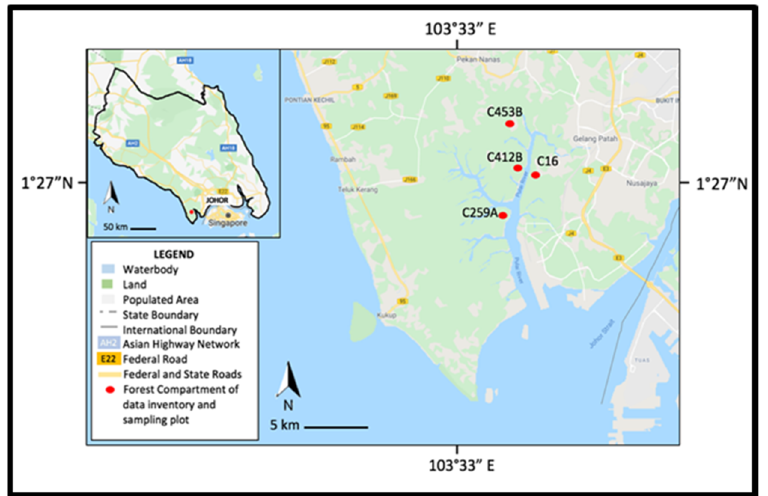
Figure 1. Study area in the Sungai Pulai Forest Reserve showing the forest compartment of the data inventory sampling plot.